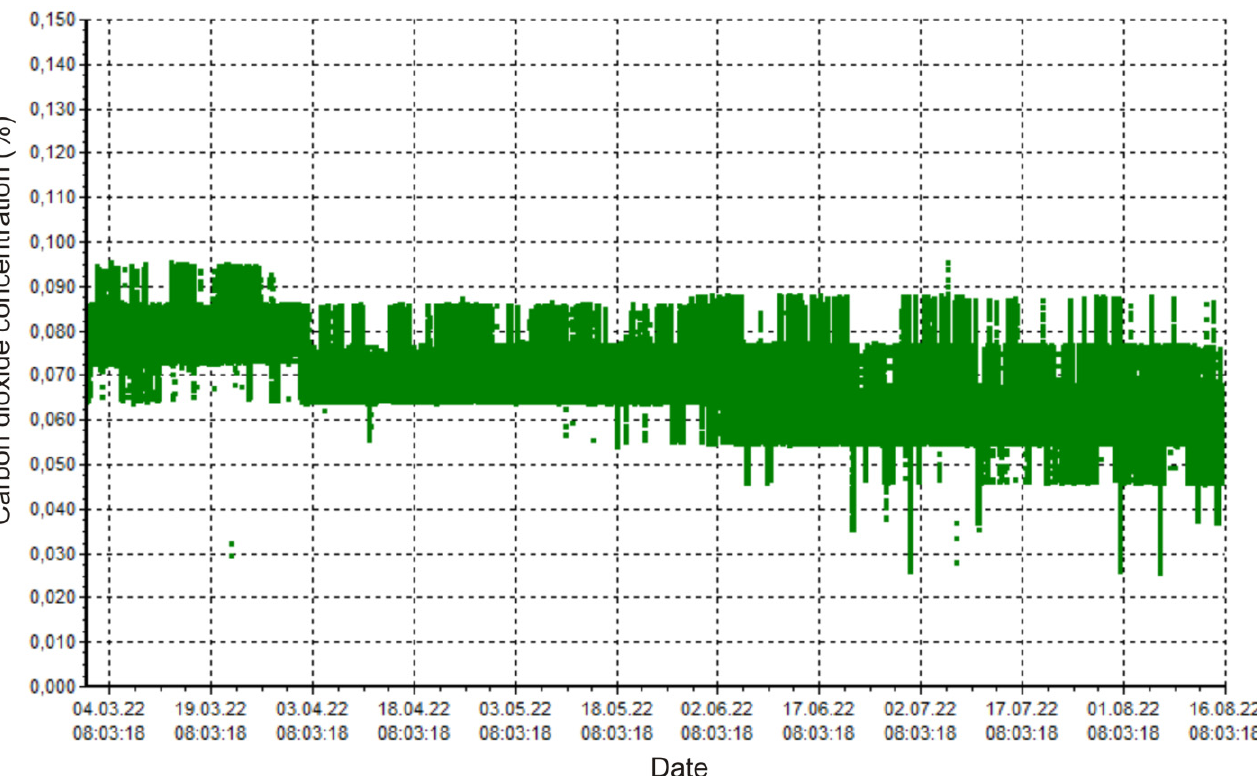
Figure 12. Seasonal dynamics of measured carbon dioxide (CO 2 ) concentration in near-surface air.